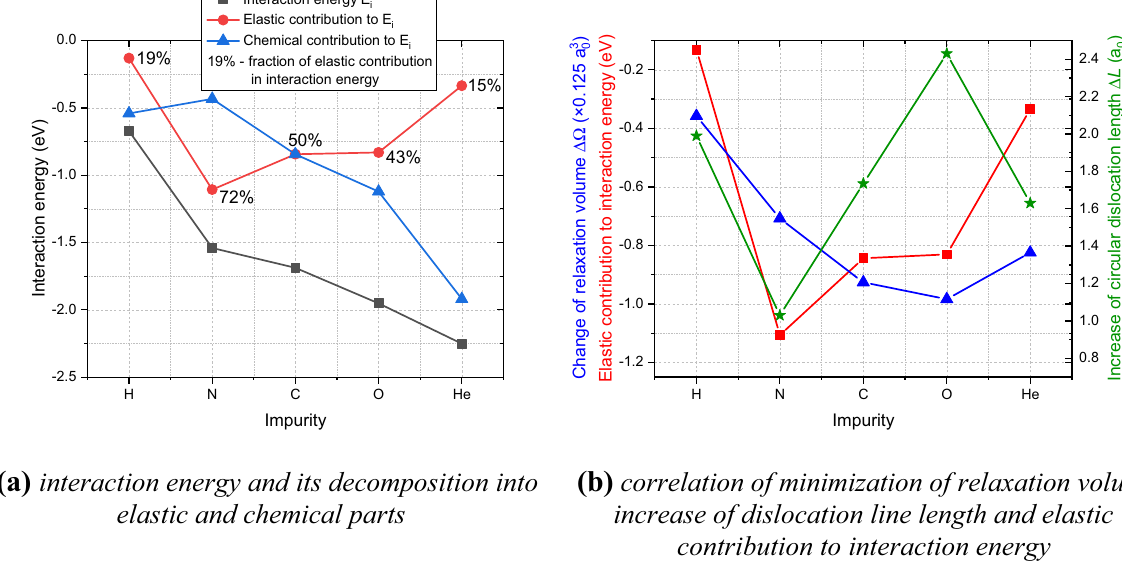
Figure 3. Elastic and chemical contributions to the interaction energy ( a ) and correlation of elastic contribution, minimization of relaxation volume (cid:31)(cid:30) and increase of dislocation length (cid:31) L ( b ) for various impurities at a dislocation loop of 37 SIAs in bcc W.